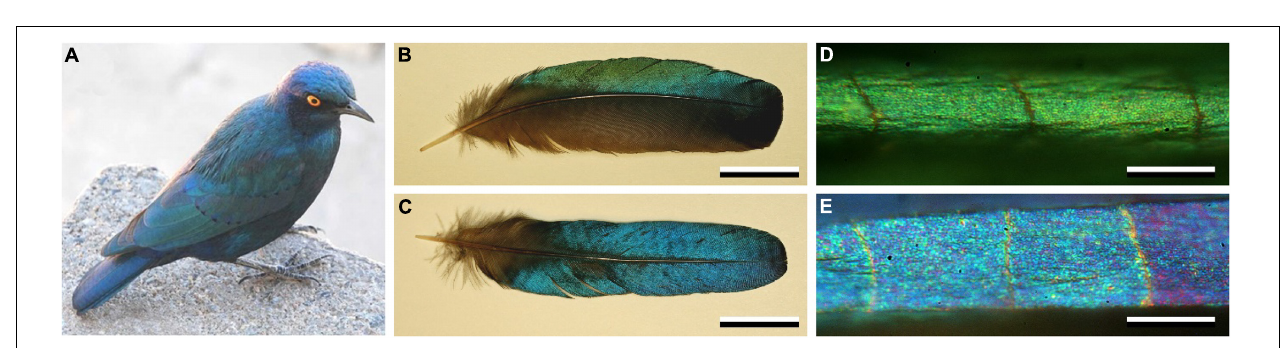
FIGURE 5 | The Cape starling ( L. nitens ) and its structural colors. (A) A starling with its main blue and some green feathers (photograph by T. Schoch). (B,C) Photographs of a (B) green secondary feather and (C) a blue tail feather. (D,E) Epi-illumination light microscope images of (D) a secondary feather barbule and (E) a tail feather barbule. Scale bars: (B,C) 2 cm, (D,E) 20 µ m.